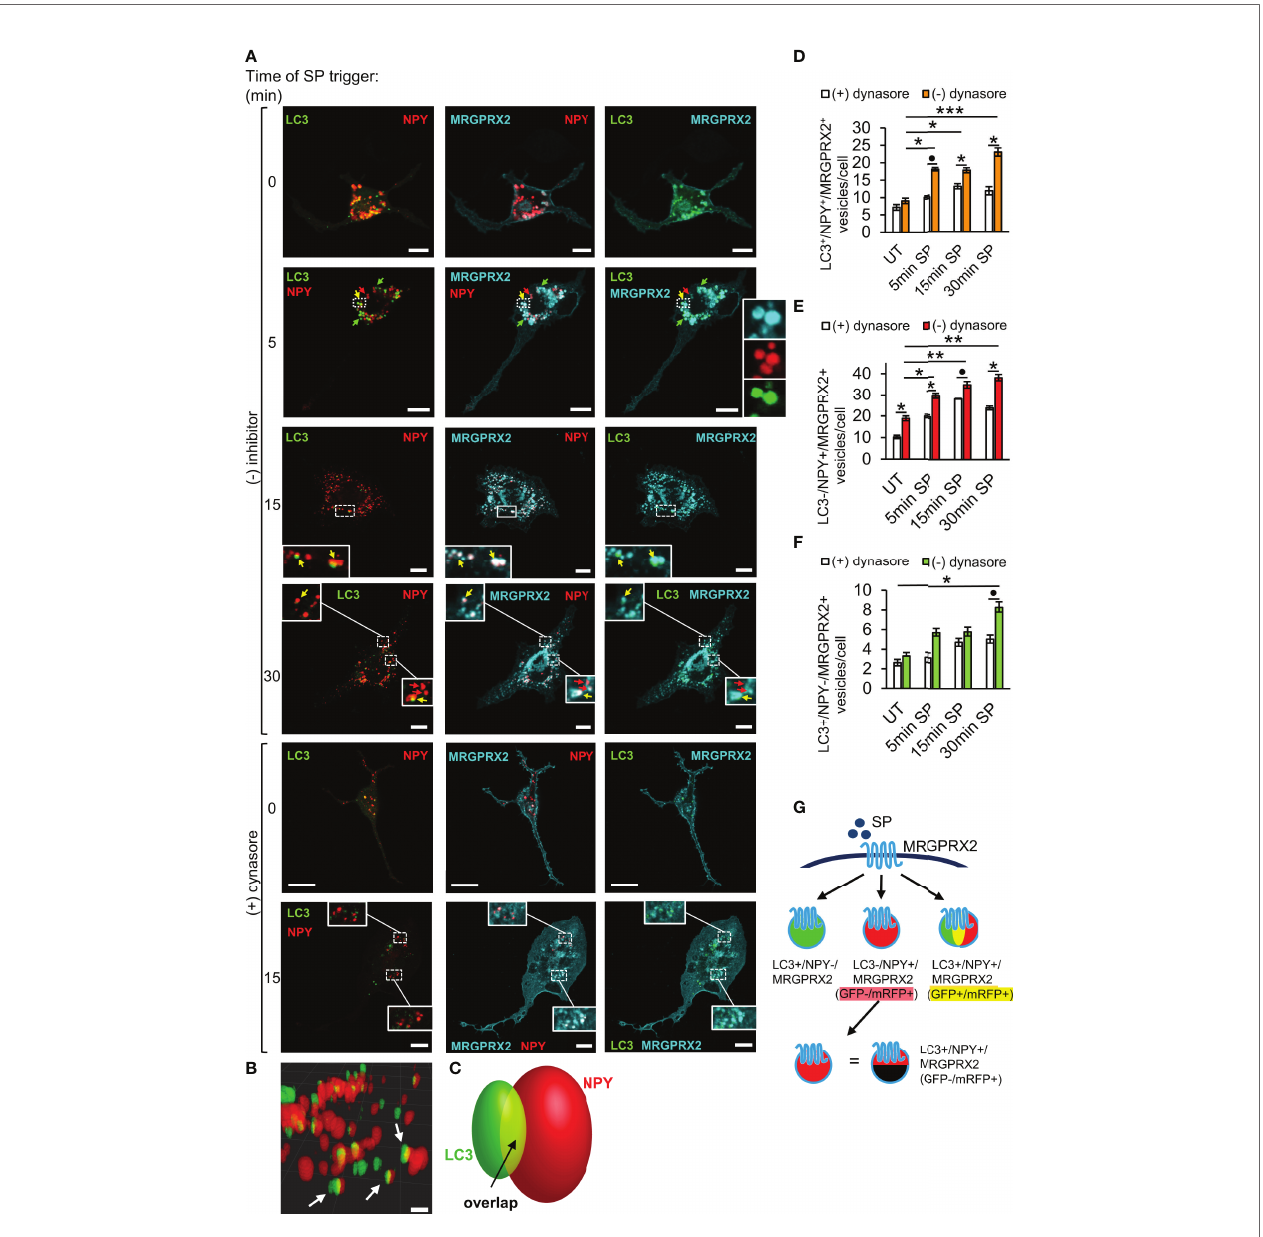
FIGURE 4 | LC3 and dynamin assist MRGPRX2 traf fi cking to SGs. RBL-MRGPRX2 cells, transiently co-transfected with NPY-mRFP (red) and LC3-GFP (green), were triggered for the indicated time periods with 10 µM SP, in the presence of vehicle or following 30 min pre-incubation with 80 µM dynasore, as indicated (A) . Cells were immunostained with anti-HA antibodies followed by Alexa Fluor ® 647-conjugated secondary antibodies (pseudo colored cyan). Yellow arrows point to MRGPRX2 that is localized to NPY-mRFP and LC3-positive SGs, red arrows point to NPY-mRFP-positive, but LC3 negative SGs, and green arrows point to LC3 positive, but NPY-mRFP negative vesicles. Enlargements correspond to the boxed areas. Scale bars = 10µm. Confocal images of cells that were activated for 15 min with SP, were 3-dimensionally reconstructed by using Imaris software (scale bars 2 µm) (B) . Arrows point to LC3 + /NPY + vesicles. A scheme of a 3-dimensionally reconstructed LC3 + /NPY + vesicle is shown in (C) , showing that some of the fl uorescence of LC3-GFP overlaps with NPY-mRFP (yellow). The average number of LC3 + /NPY + /MRGPRX2 + (D) , LC3 - /NPY + /MRGPRX2 + (E) , or LC3 + /NPY - /MRGPRX2 + (F) vesicles/cell was calculated using the ImageJ software and is presented as the mean ± SEM from three to six independent experiments, with each experiment including at least 20 cells/condition. Statistical signi fi cance was determined by one-way ANOVA, followed by Dunnett ’ s post-test, for comparison of UT with different time points of SP trigger in D-F: * P < 0.05, ** P < 0.01, *** P < 0.001, or unpaired two-tailed Welch ’ s t-test comparison SP ± dynasore for D, * P [LC3 + /NPY + /MRGPRX2 + - 5 min: SP vs. SP + dynasore] = 0.0652, for E, * P [LC3 + /NPY + / MRGPRX2 + - 15 min: SP vs. SP + dynasore] = 0.0220, * P [LC3 + /NPY + /MRGPRX2 + - 30 min: SP vs. SP + dynasore] = 0.0365, and for F, * P [LC3 - /NPY + /MRGPRX2 + - UT: SP vs. SP + dynasore] = 0.0191, * P [LC3 - /NPY + /MRGPRX2 + - 5 min: SP vs. SP + dynasore] = 0.0238, * P [LC3 - /NPY + /MRGPRX2 + - 15 min: SP vs. SP + dynasore] = 0.1049 and * P [LC3 - /NPY + /MRGPRX2 + - 5 min: SP vs. SP + dynasore] = 0.0216. A schematic presentation of the types of vesicles into which MRGPRX2 internalizes in response to SP trigger is shown in (G)